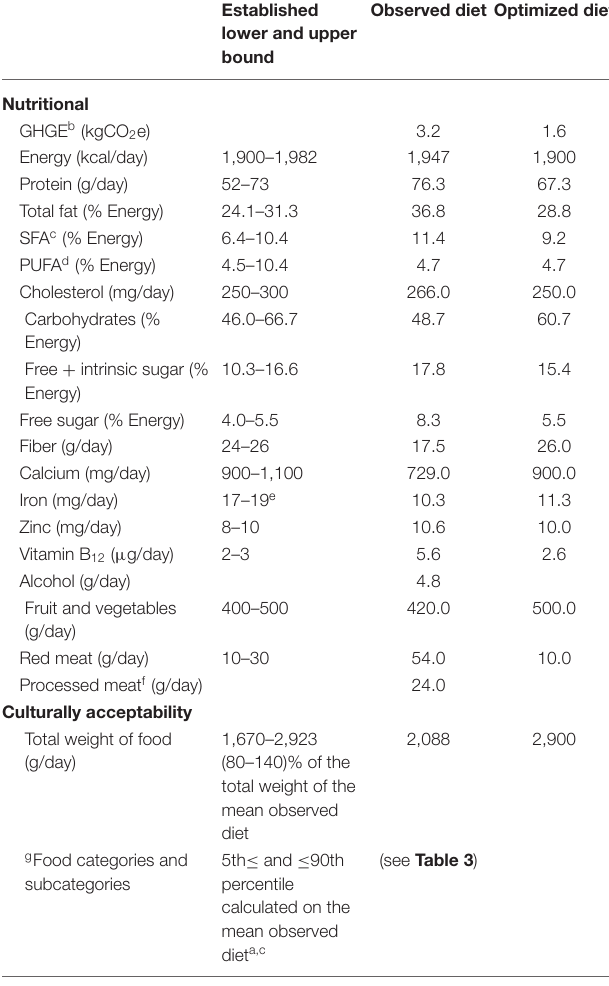
TABLE 2 | Nutritional constraints for daily intake requirements compared with the mean observed diet (INRAN-SCAI 2005–2006) and the optimized diet from linear programming model for the adult female population, 18–60 years a